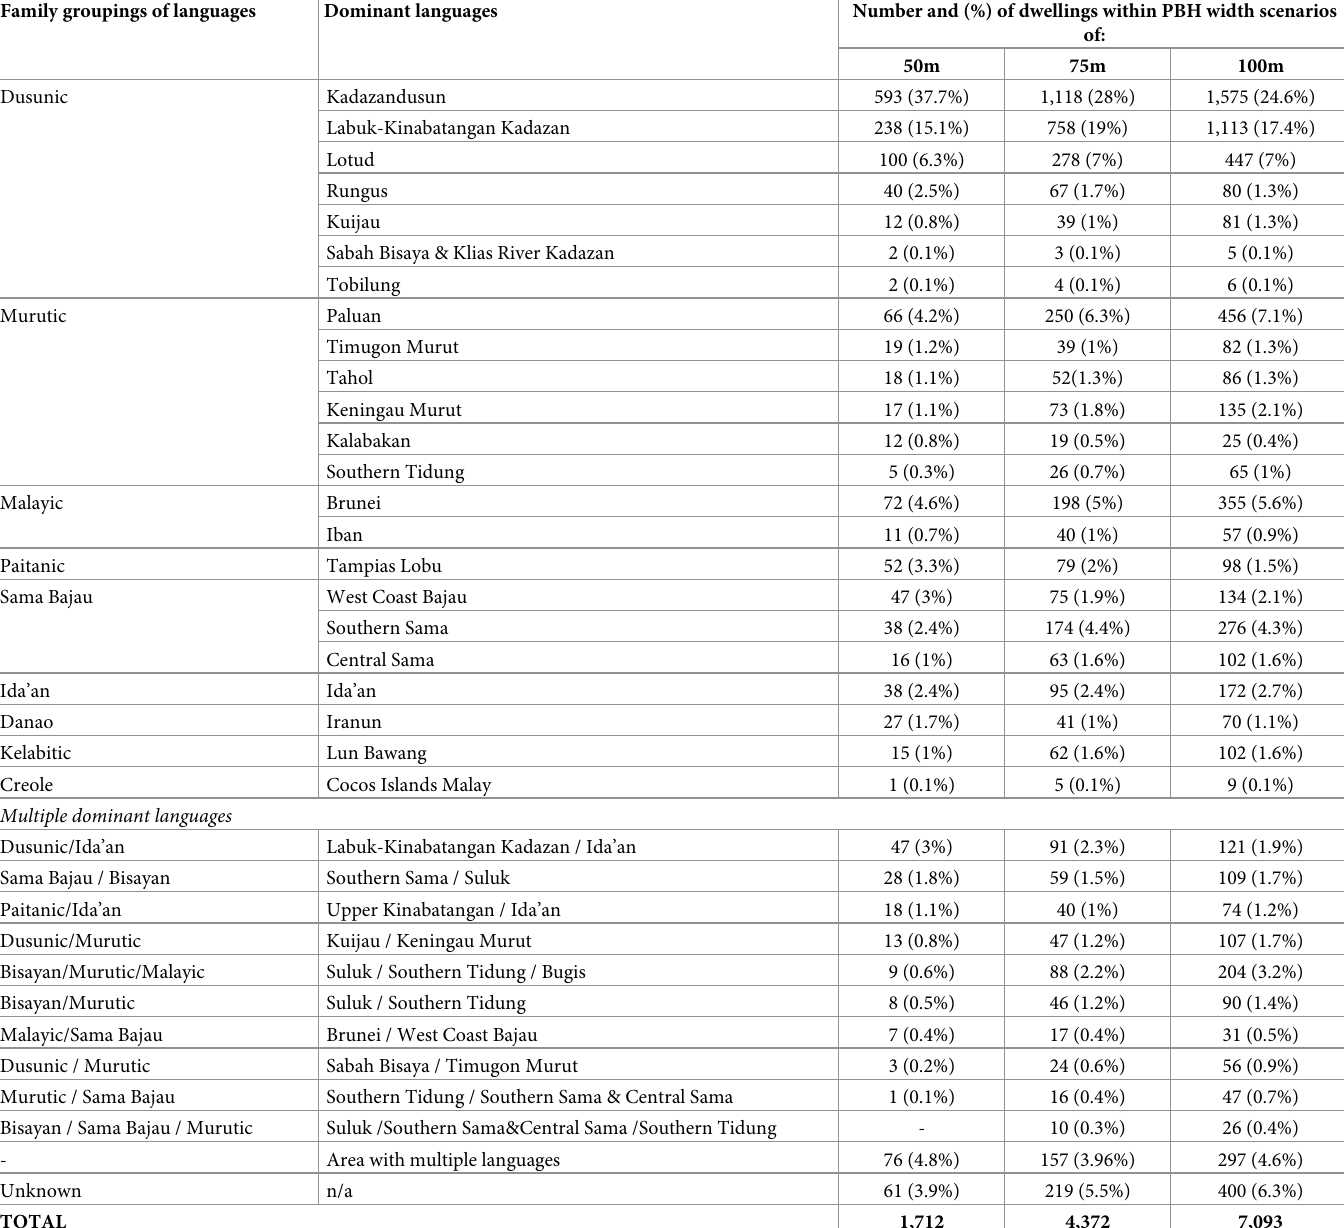
Table 2. Number and % of dwellings per Indigenous group within the three width scenarios. Family groupings of